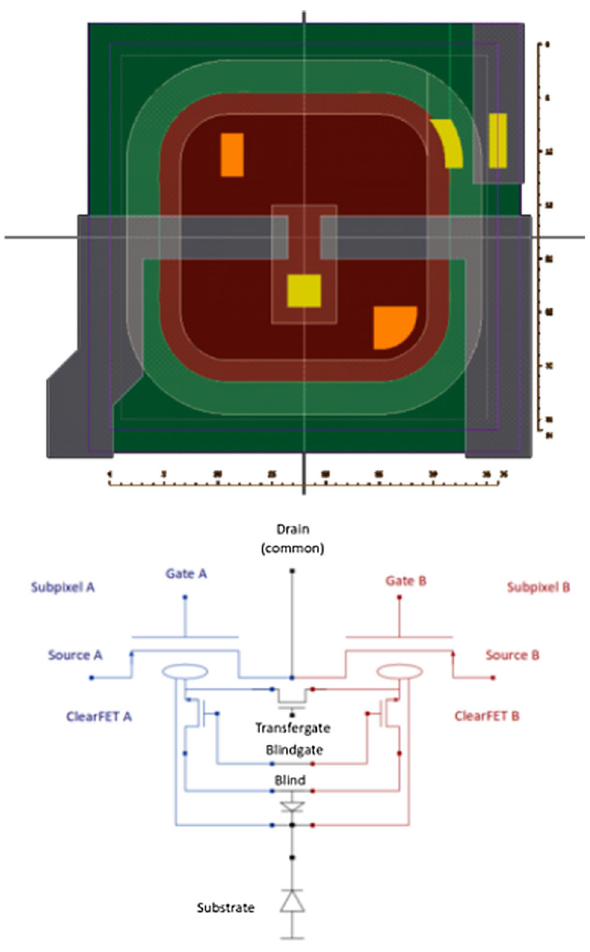
Fig. 9 Layout (top) and equivalent circuit representation (bottom) of RNDR superpixel with electronic shutter. The pixel size here is 36 × 36 µ m